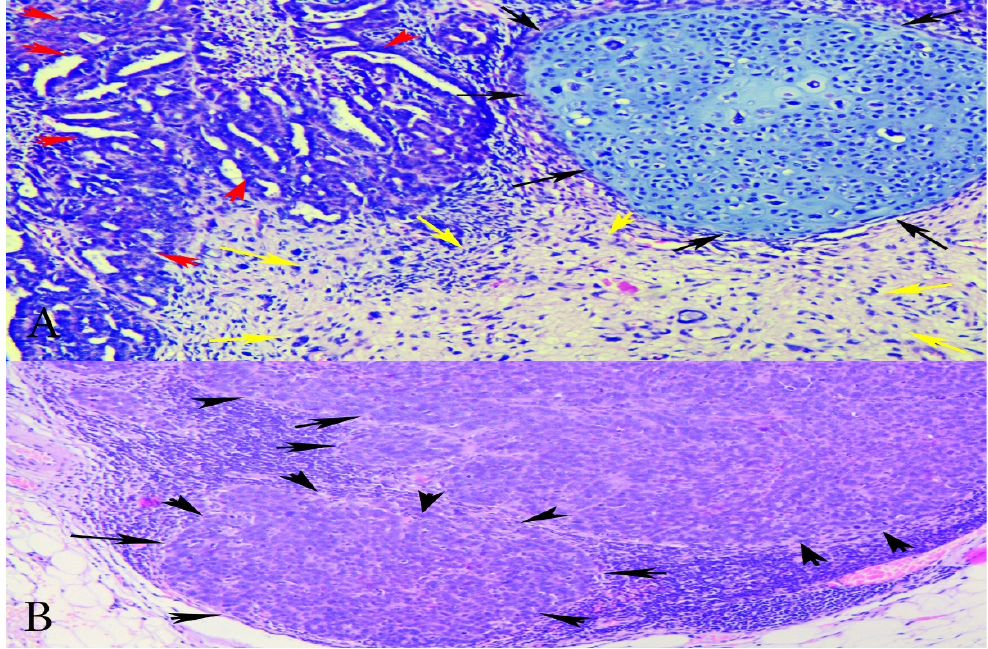
Figure 2. ( A ) Microphotographs of the tumour showing carcinoma and sarcoma components— H&Ex200-carcinomatous with high-grade serous carcinoma and sarcomatous component with stromal and chondroid differentiation. Red arrows—serous epithelial carcinoma; black arrows— chondrosarcoma; yellow arrows—endometrial stromal sarcoma. ( B ) Metastatic lymph node—HEx100 lymph node with metastases of carcinomatous (high-grade serous) component. Black arrows—lymph node metastases from the epithelial component.